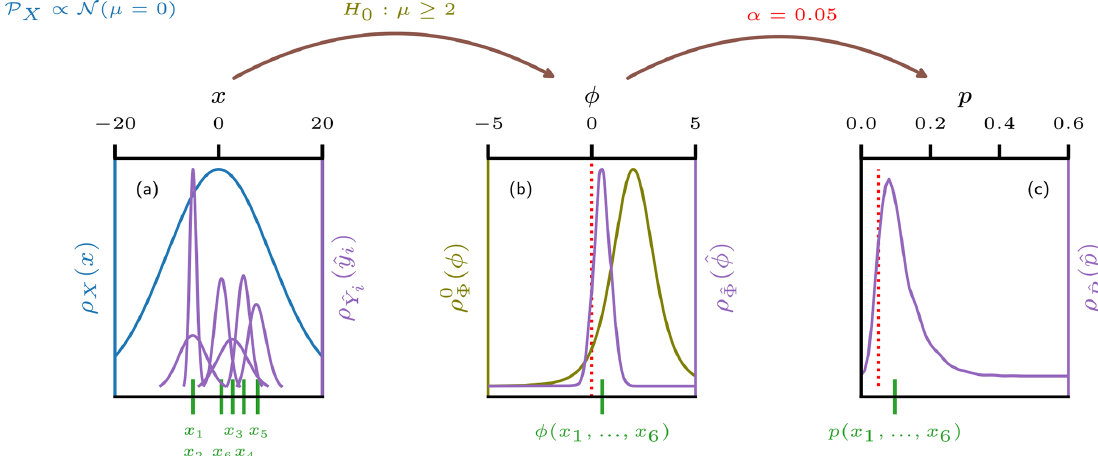
Figure 4. (a) Schematic representation of an uncertain observation of a sample (purple) generated from a population (blue) in a random experiment. The blue line indicates the probability density of the generating population P X . Green lines indicate the true value of a sample x = ( x 1 ,...,x 6 ) realized from P X . If the observational process involves uncertainty, a second level of randomness is introduced and the values can at best be approximated by probability density functions depicted in purple. These uncertainty distributions indicate the informed estimate of the observer about how likely a certain value ˆ y i for the estimator ˆ Y i is to coincide with the true value x i . Depending on the measurement process, the uncertainty distributions of the sample members may all exhibit individual shapes or they may share a common one. (b) Distribution of the uncertain test statistic ˆ (cid:56) = φ ( ˆ Y ) derived from the uncertain sample (purple) together with the corresponding value derived from the true sample (green). In olive, the distribution of (cid:56) under the null hypothesis is shown. The dotted red line separates the rejection region (left) from the acceptance region in a one-sided test setup. (c) Distribution of the uncertain p value corresponding to the uncertain sample. In green, the p value of the certain sample is marked. The red line indicates the significance level α